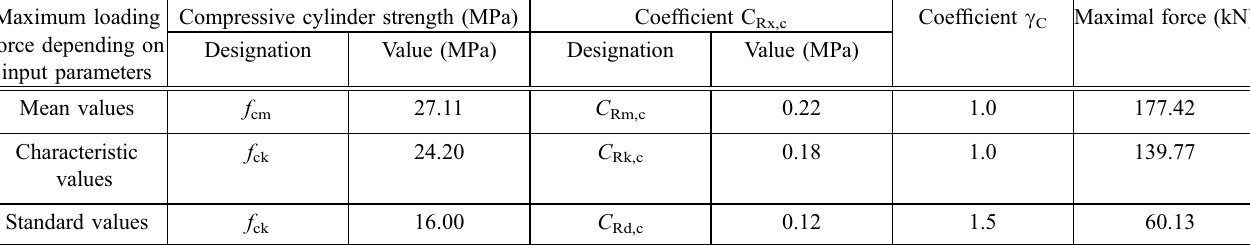
Table 2 Maximum force in press according to the used value of strength.